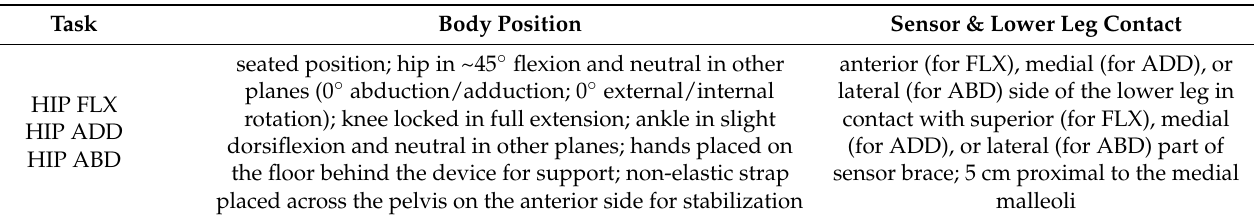
Table 1. Description of the